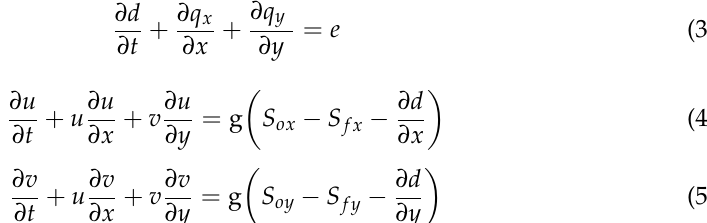
Figure 5. Digital elevation model (DEM) for the target area.